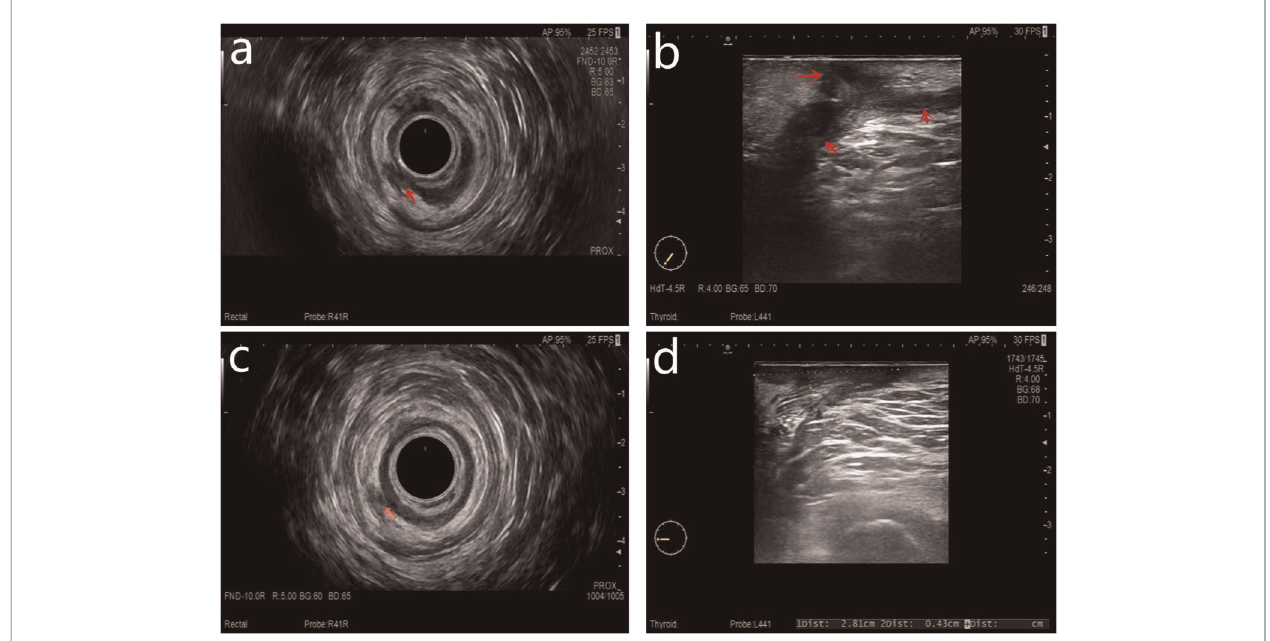
FIGURE 3 | Both preoperative anal fi stula and postoperative complete healing were demonstrated on a follow-up anorectal ultrasound scan. ( A ) Preoperation transrectal biplanar probe scans, ( B ) preoperation percutaneous super fi cial probe scans, ( C ) postoperation follow-up transrectal biplanar probe scans of healed fi stula, and ( D ) postoperation follow-up percutaneous super fi cial probe scans of healed fi